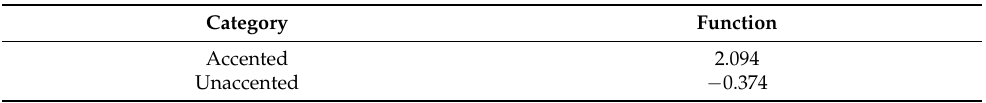
Table 7. Functions at Group Centroids.